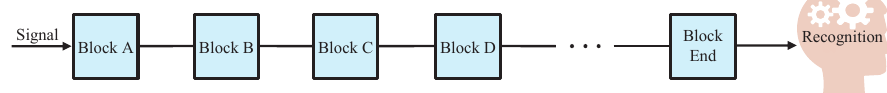
Figure 2. Gain control distribution within the audio signal flow of the ASR